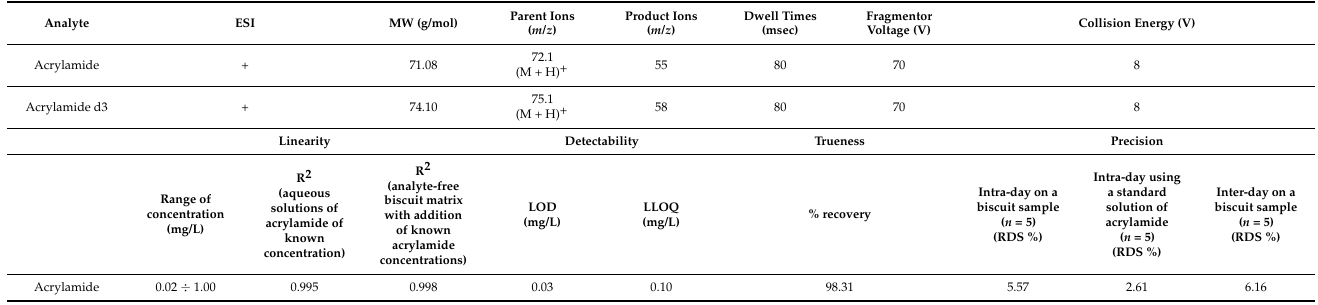
Table 2. List of the main MS parameters optimized and results of the method